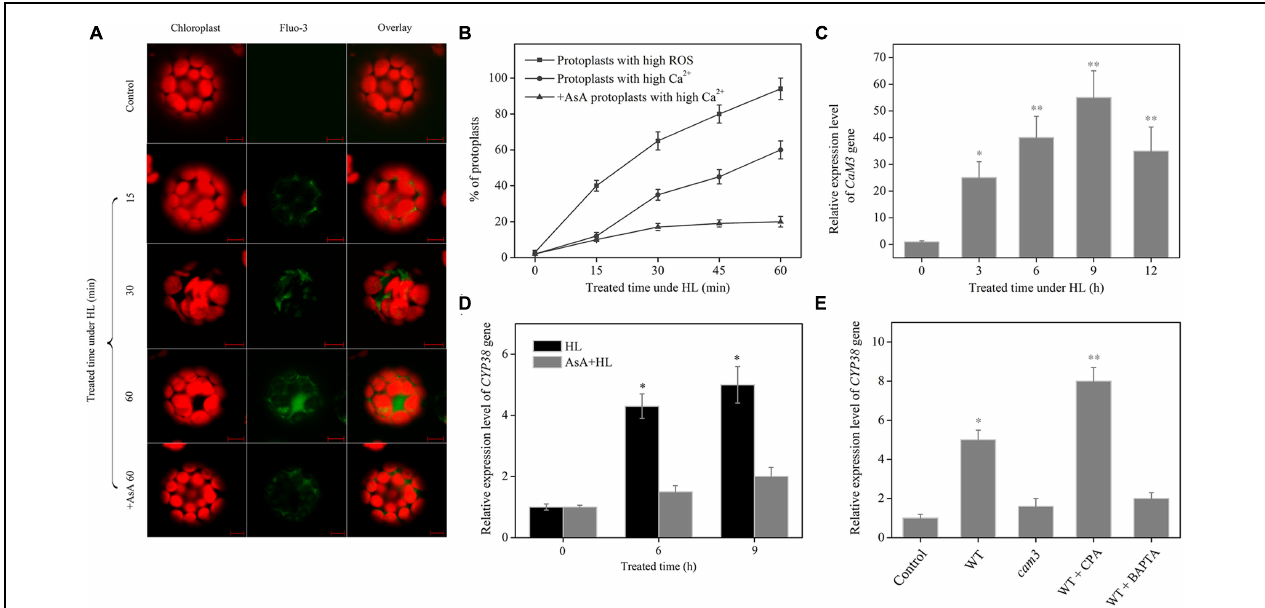
FIGURE 7 | Effect of ROS and Ca 2 + -CaM3 cascade on CYP38 gene expression. (A) Sub-cellular localization and content of HL-induced Ca 2 + production. Protoplasts were treated with or without HL for the indicated time period, then incubated with Fluo-3-AM for 30 min at room temperature, and observed using LCSM as described in materials and methods. Chloroplast autofluorescence is false colored red, and Fluo-3 fluorescence is false colored green. Scale bars = 10 µ m. (B) Kinetics of changes in ROS and Ca 2 + level by flow cytometry analysis after HL treatment. (C) Changes in CAM3 gene expression in HL-treated Arabidopsis WT plants. (D) CYP38 gene expression in the detached leaves of WT with or without AsA. (E) CYP38 gene expression in the detached leaves of WT with or without BAPTA-AM (1 mM) or CPA (1 µ M) in response to HL treatment. Total RNAs were extracted from the HL-treated plants at the indicated time for the qRT-PCR analysis. Before HL treatment, the protoplasts and detached leaves were incubated with AsA at 1 mM final concentration. values for three replicates and asterisks ( ∗ ) indicate a significant difference from the Control at ∗ P < 0.05, ∗∗ P < 0.01.